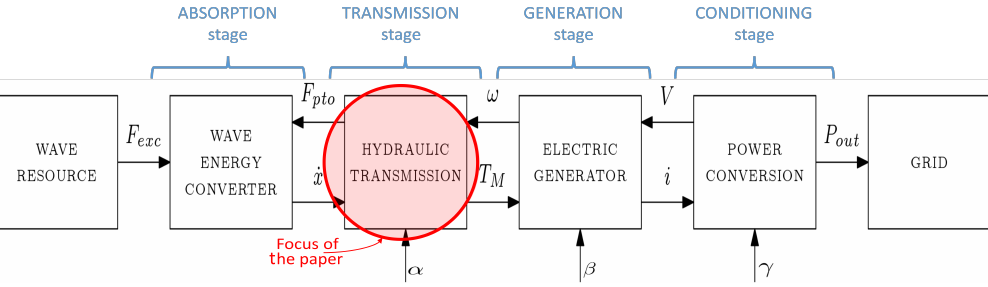
Figure 1. Full conversion chain of a wave energy converter with hydraulic PTO, adapted from